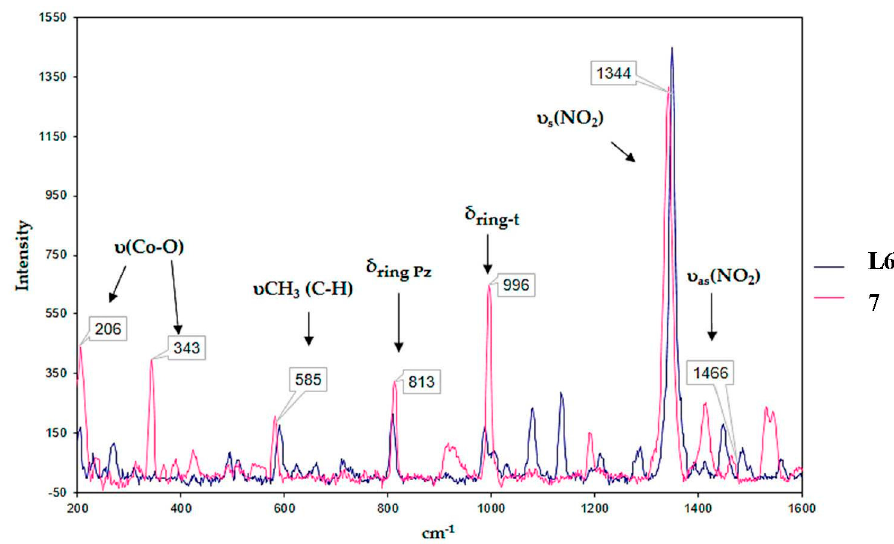
Figure 4. Comparison of absorption spectra in the Raman region of L6 and 7 .